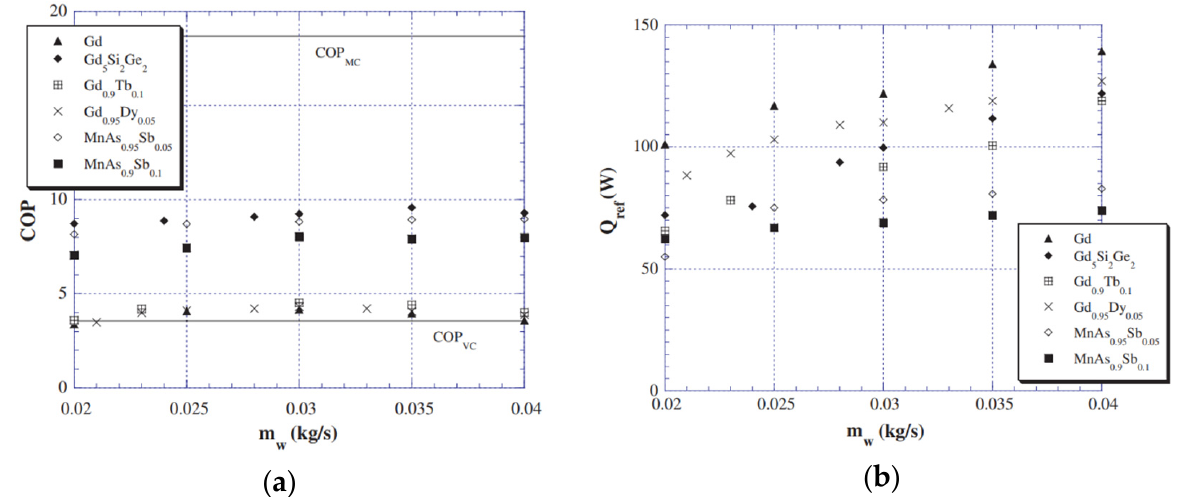
Figure 21. Comparison between the SOMT and the FOMT for different magnetic materials: ( a ) COP and ( b ) refrigeration power as a function of water mass flow rate [72].